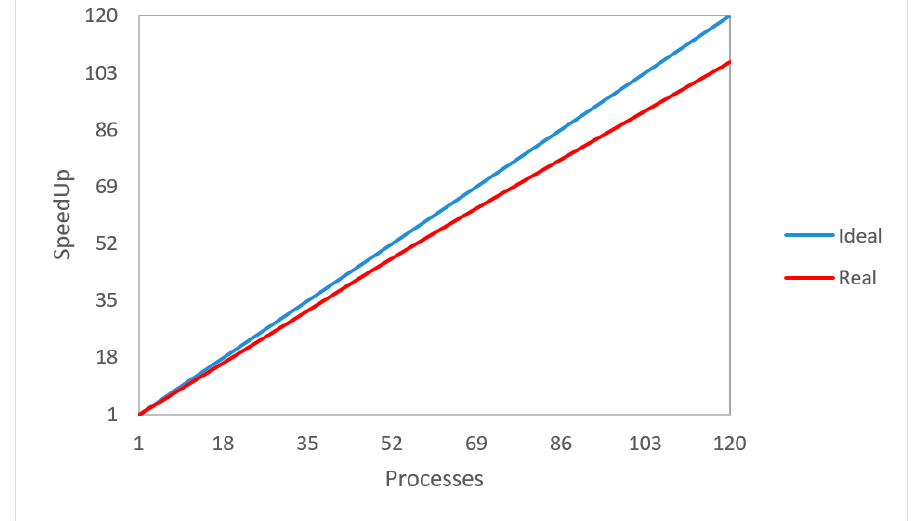
Figure 10. Average speedup for the HGAG algorithm for RFFS_SDST_80 × 4 × 4 × 25 problem. Evaluation of the communications overload on the Grid